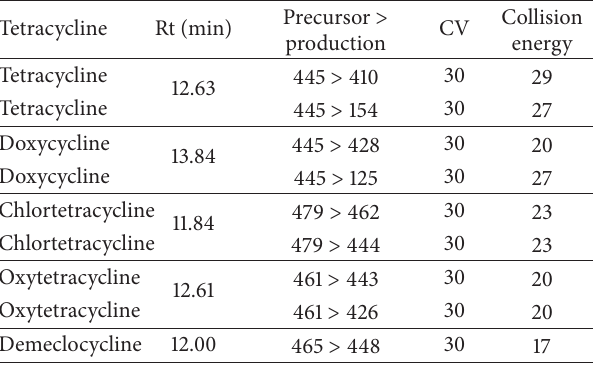
Table 1: Retention time (Rt), cone voltage (CV), collision energy, precursor, and product ions employed for ion